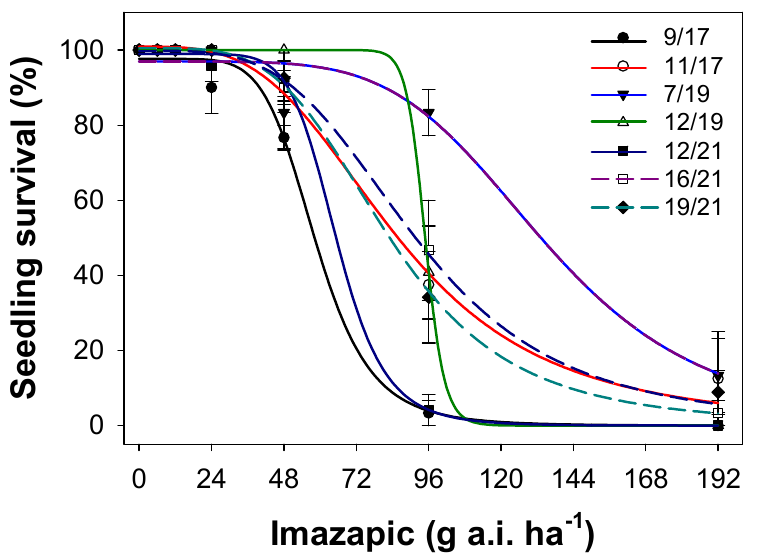
Figure 5. Effect of imazapic dose on survival of seven populations of Chloris virgata . The most susceptible population was 9/17. Plants were sprayed at the four–five leaf stage of each population.